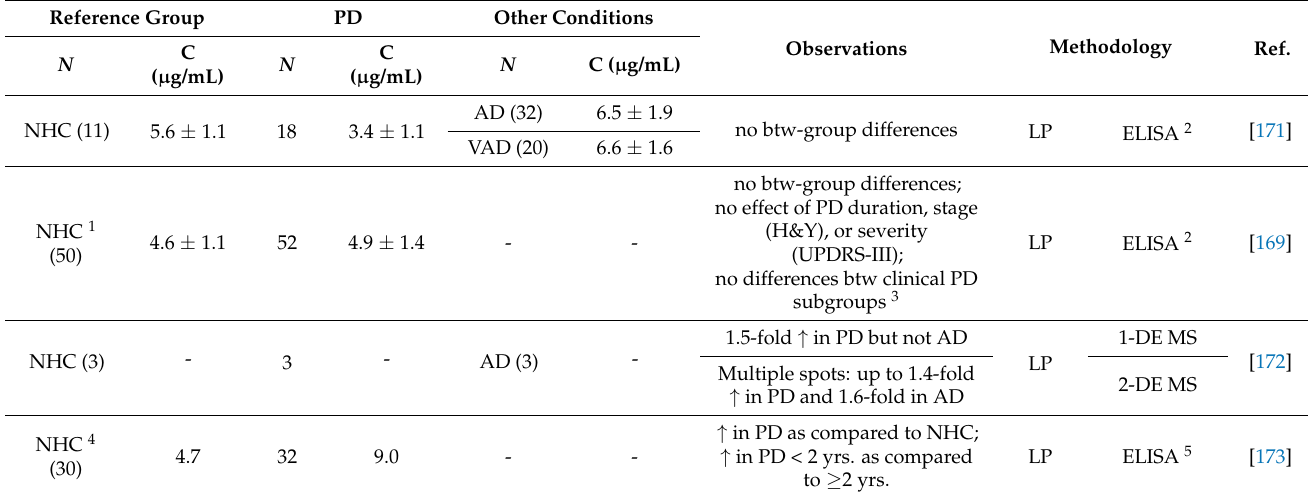
Table 1. Summary of studies on cerebrospinal fluid (CSF) clusterin in Parkinson’s